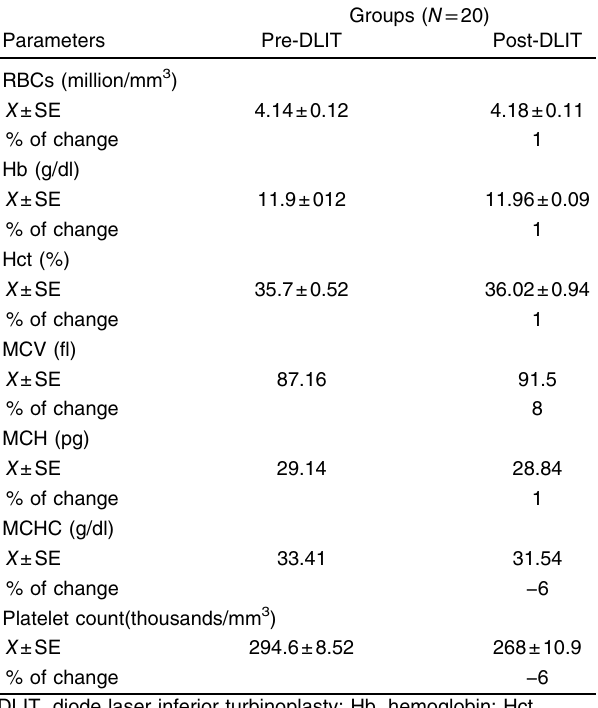
Percentage of change in red blood cells count, hemoglobin level, hematocrit value, and platelet count after DLIT. DLIT, diode laser inferior